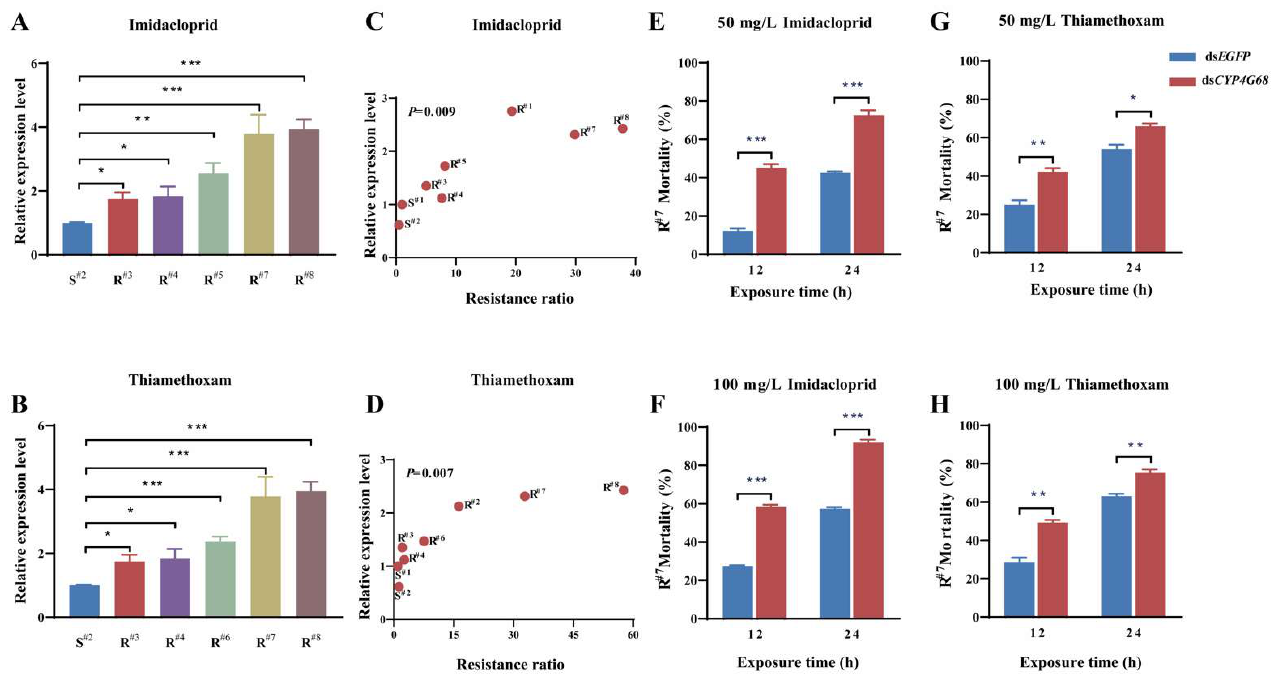
Figure 5. Functional validation of CYP4G68 in field populations. ( A , B ) The expression profiles of CYP4G68 in resistant (imidacloprid or thiamethoxam) strains and susceptible strains. ( C , D ) Linear regression analysis between resistance (imidacloprid or thiamethoxam) levels and relative CYP4G68 expression. ( E – H ) Susceptibility of the resistant strain (R #8 ) of B. tabaci MED to imidacloprid ( E , F ) and thiamethoxam ( G , H ) after RNAi knockdown of CYP4G68 . Values are the means ± SEM ( n = 3), with asterisks representing significant differences between the treatments and the control (* p < 0.05, ** p < 0.01, *** p < 0.001).